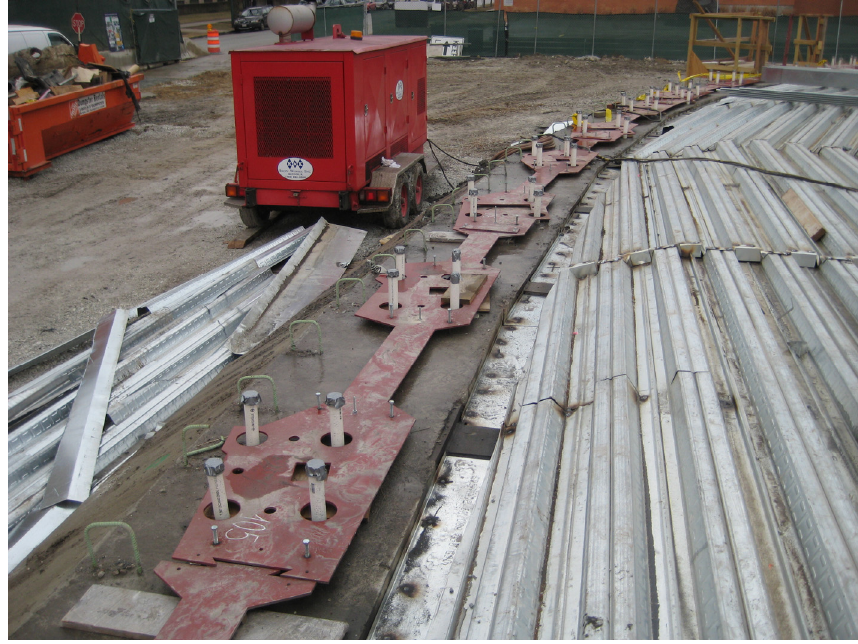
Figure 12: The site in March 2010 – Installation of dome pipe setting plates (© Halvorson and